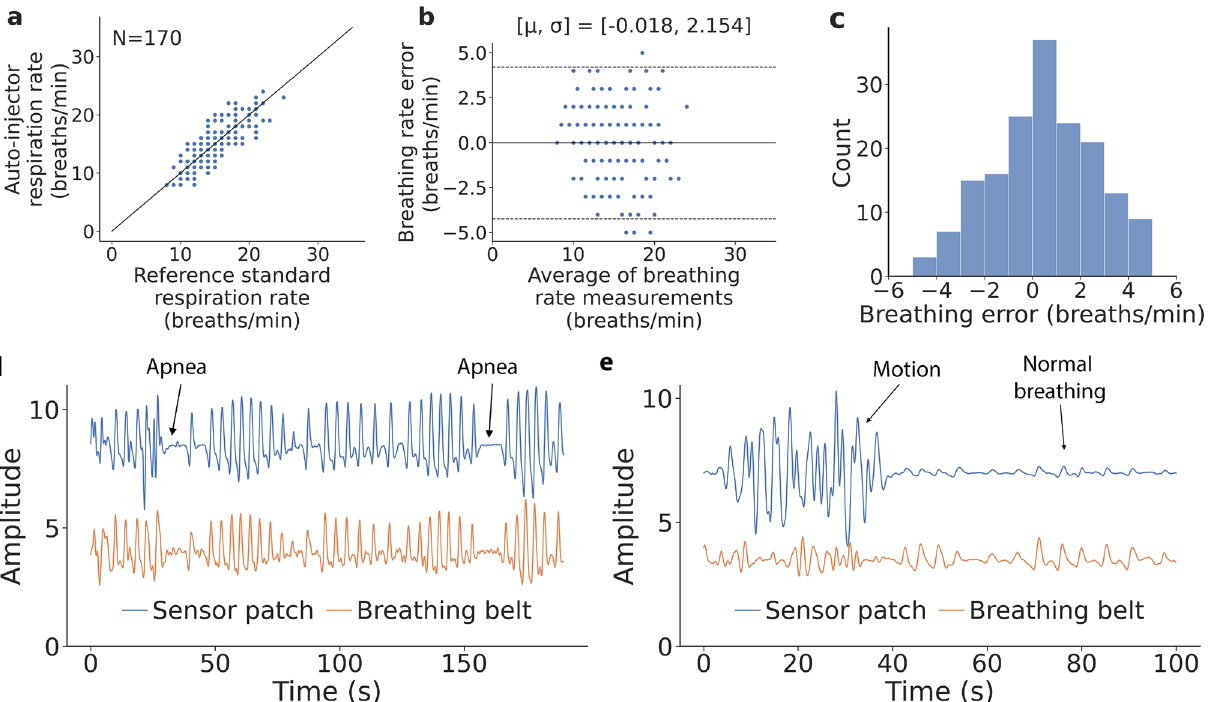
Figure 2. Measurement of opioid use events in the supervised injection facility. ( a ) Correlation and ( b ) Bland– Altman plots comparing breathing rate from respiration belt and wearable sensor patch. In the Bland–Altman plot µ is the mean error and σ is the standard deviation (SD) of the errors, the solid line represents the mean error and the dotted lines represent the 95% limits of agreement. ( c ) Histogram of breathing rate error. ( d ) Breathing signal from sensor patch and breathing belt showing normal breathing, post-injection apneas and ( e ) human motion events at the supervised injection